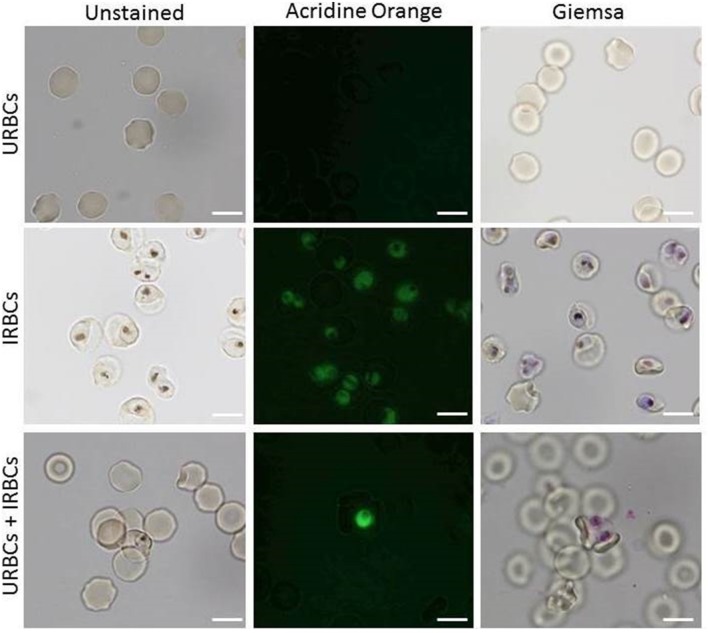
IRBC, URBC, and IGFBP7.URBC, IRBC, and URBC+ IRBC exposed to IGFBP7 visualized with unstained, acridine orange and Giemsa wet mounts, which are the common techniques for rosetting assay. Pictures taken with Nikon Eclipse E200 light microscope. Scale bars represent 10 µm.